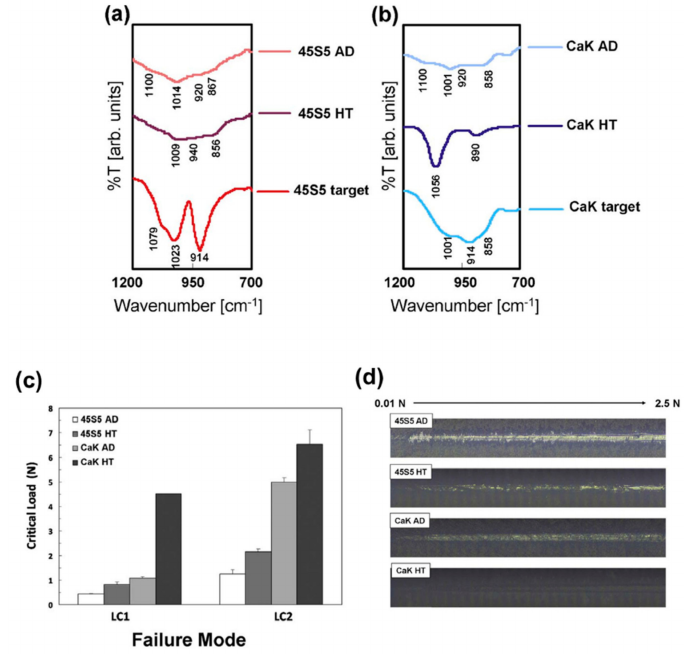
Figure 9. Fourier-transform infrared spectroscopy (FT-IR) spectra of 45S5 ( a ) and CaK ( b ) targets and for as-deposited and heat-treated coatings. Critical loads for partial (LC1) and complete (LC2) delamination ( c ) and optical images (objective magnitude: 5 × ) of the worn track ( d ) obtained by the micro-scratch